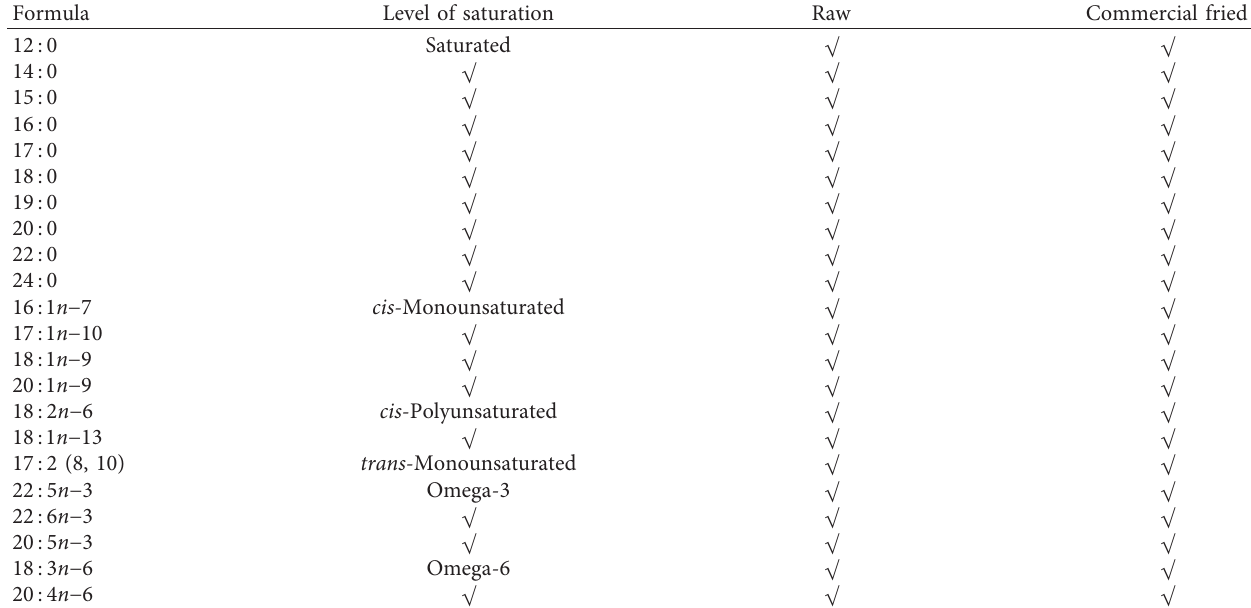
Table 1: Identified fatty acids in raw and commercial fried Nile tilapia ( Oreochromis niloticus ) fish muscles. Formula Level of saturation Raw Commercial fried